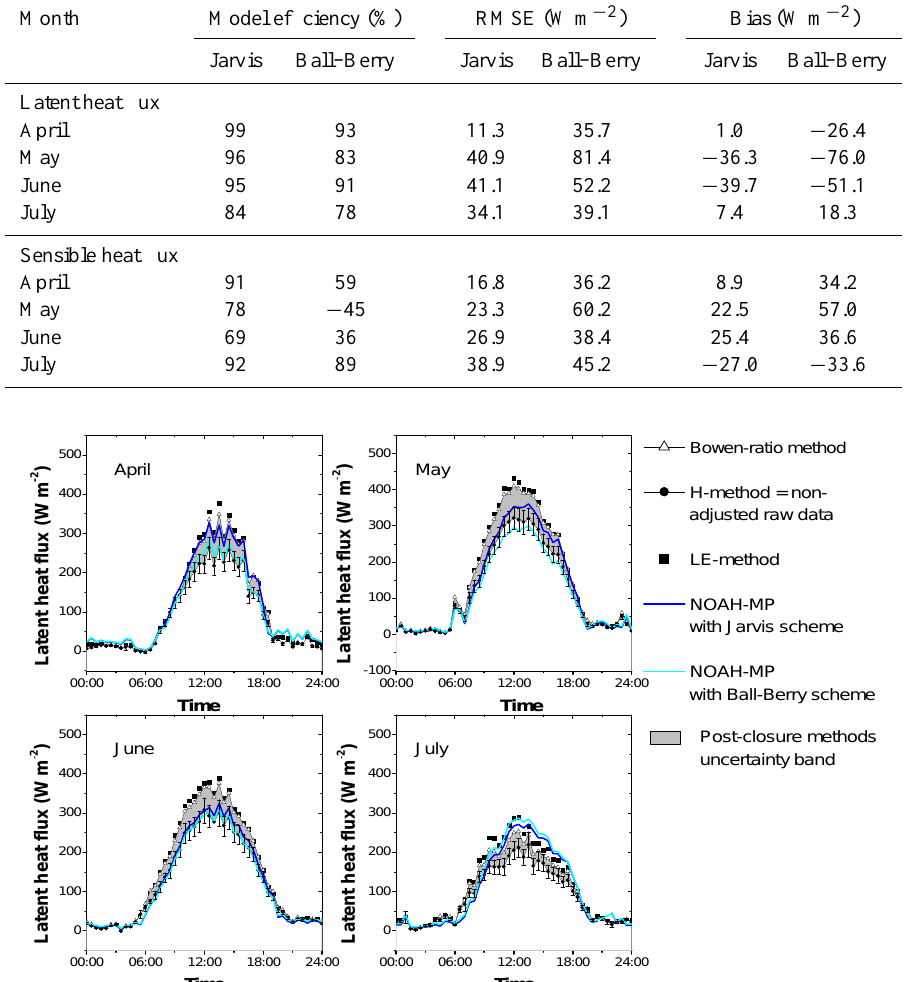
Table 3. Model performance criteria for the simulation results presented in Figs. 5 and 6. For the computation of model efficiency, root mean square error (RMSE) and bias see, for example, Ingwersen et al. (2011). The performance criteria were computed for the daytime (06:00 to 18:00UTC?).